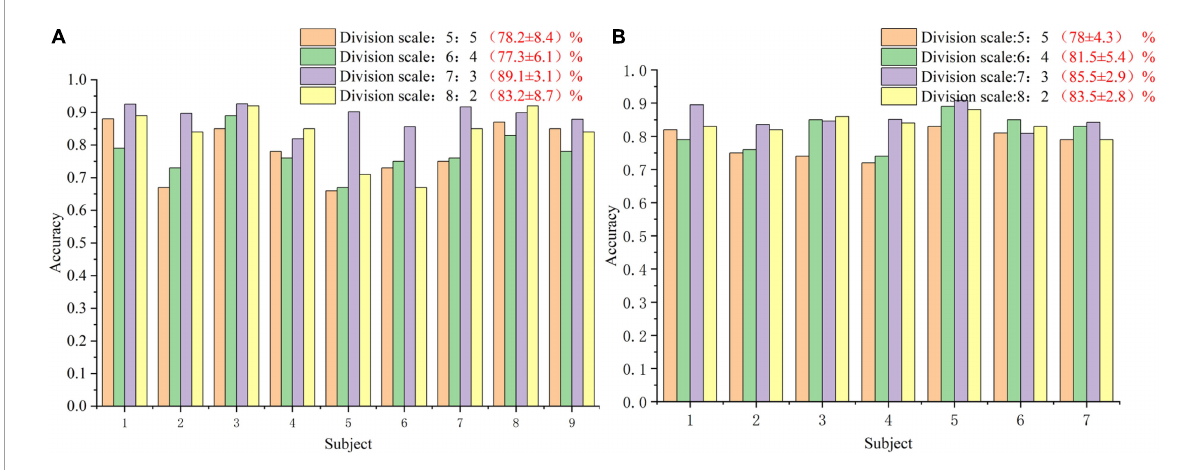
FIGURE6 The classification accuracy curve at different training sizes. (A) The result of public dataset 1. (B) The result of public dataset 2.